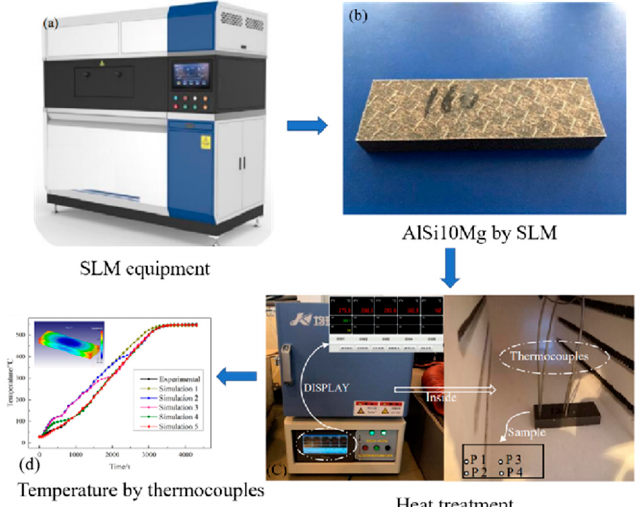
Figure 2. The process of heat treatment temperature measurement.( a ) The SLM printing equipment. ( b ) The size of the AlSi10Mg sample. ( c ) The thermocouple is inserted into a small hole on the surface of the sample to measure and obtain the temperature data during the heat treatment process in real time. ( d ) The comparison curve of the measured temperature and the simulated temperature.